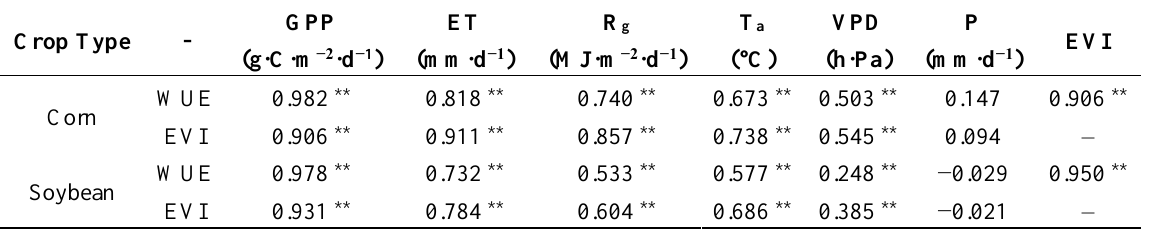
Figure 3. Seasonal variations of ecosystem water use efficiency from flux tower measurements (WUE EC ) and estimates from MODIS products (WUE RS ) at the flux tower site US-Bo1 during 2001–2006 (corn in the odd years and soybean in the even years). Table 1. Correlations between 8-day tower-based WUE and satellite-driven EVI data with the controlling environmental factors at the annual corn/soybean rotation